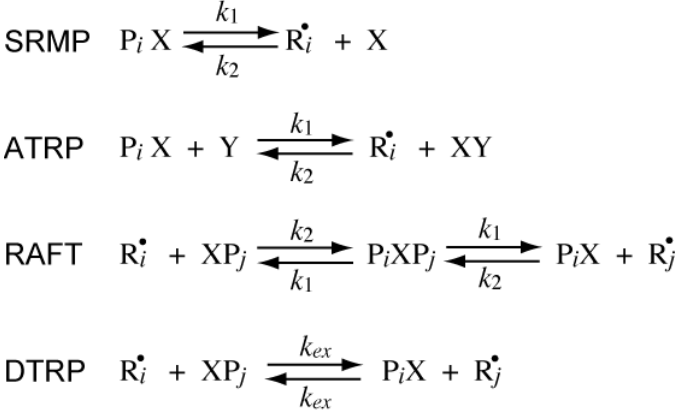
Figure 1. Reversible deactivation reaction scheme in each type of reversible-deactivation radical polymerization (RDRP). In the figure, P chain length i . R (cid:3036)• is the active polymer radical with chain length i